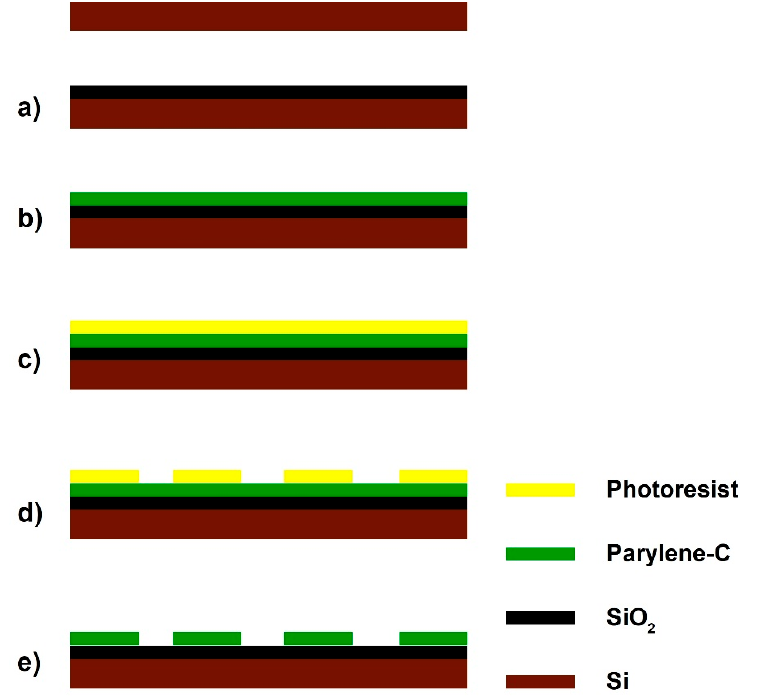
Figure 1. Fabrication flow of a parylene-C pattern: ( a ) growth of a 200 nm SiO 2 layer via thermal oxidation; ( b ) deposition of a 10–20 nm parylene-C layer; ( c ) spin coating of a positive photoresist,